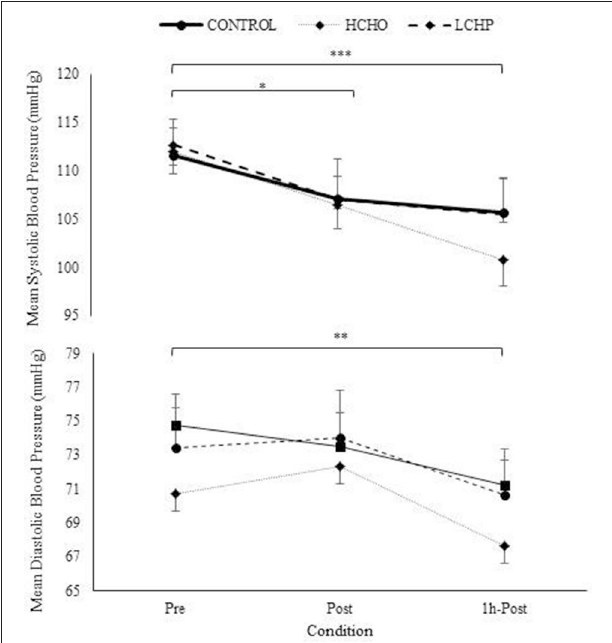
FIGURE 3 | Mean, Systolic, and Diastolic Blood Pressure at pre, post and 1h- post-exercise in control, HCHO and LCHP conditions. Values are mean ±